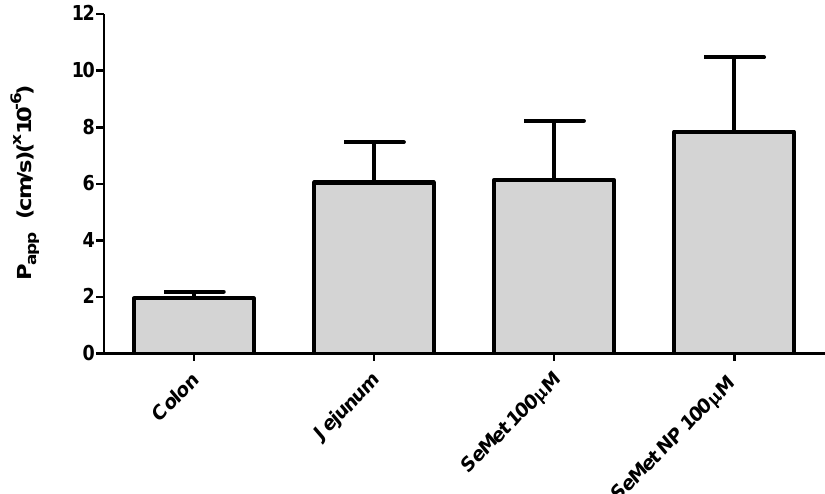
Figure 4. P app of FD4 was measured across isolate jejunal and colonic mucosae. Effect of apical addition of 100 µ M SeMet and SeMet NPs on P app on jejunal mucosae with cumulative concentration of SeMet transported across the jejunum to the basolateral side over 120 min. Each value represents the mean ±SEM with n = 3.